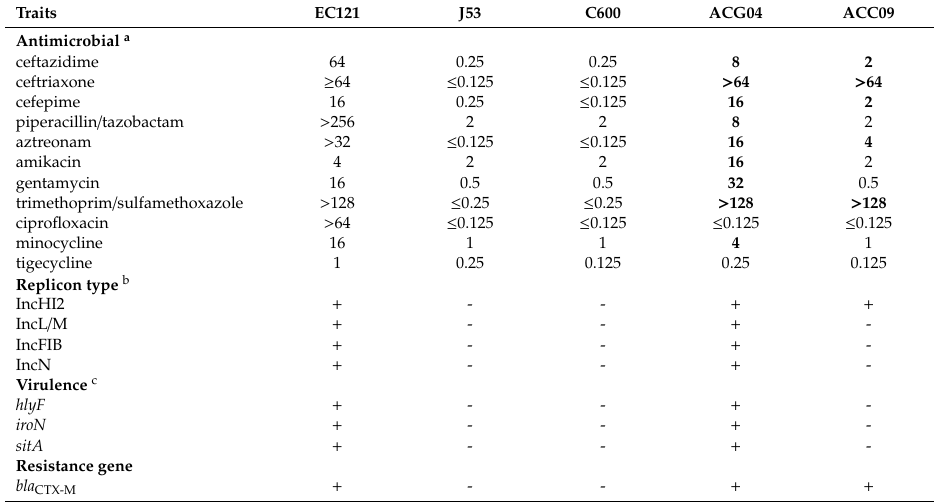
Table 5. Resistance profile, replicon type, and virulence genes identified in the EC121’s plasmids transferred to E. coli K-12 strains. Traits Antimicrobial a ceftazidime